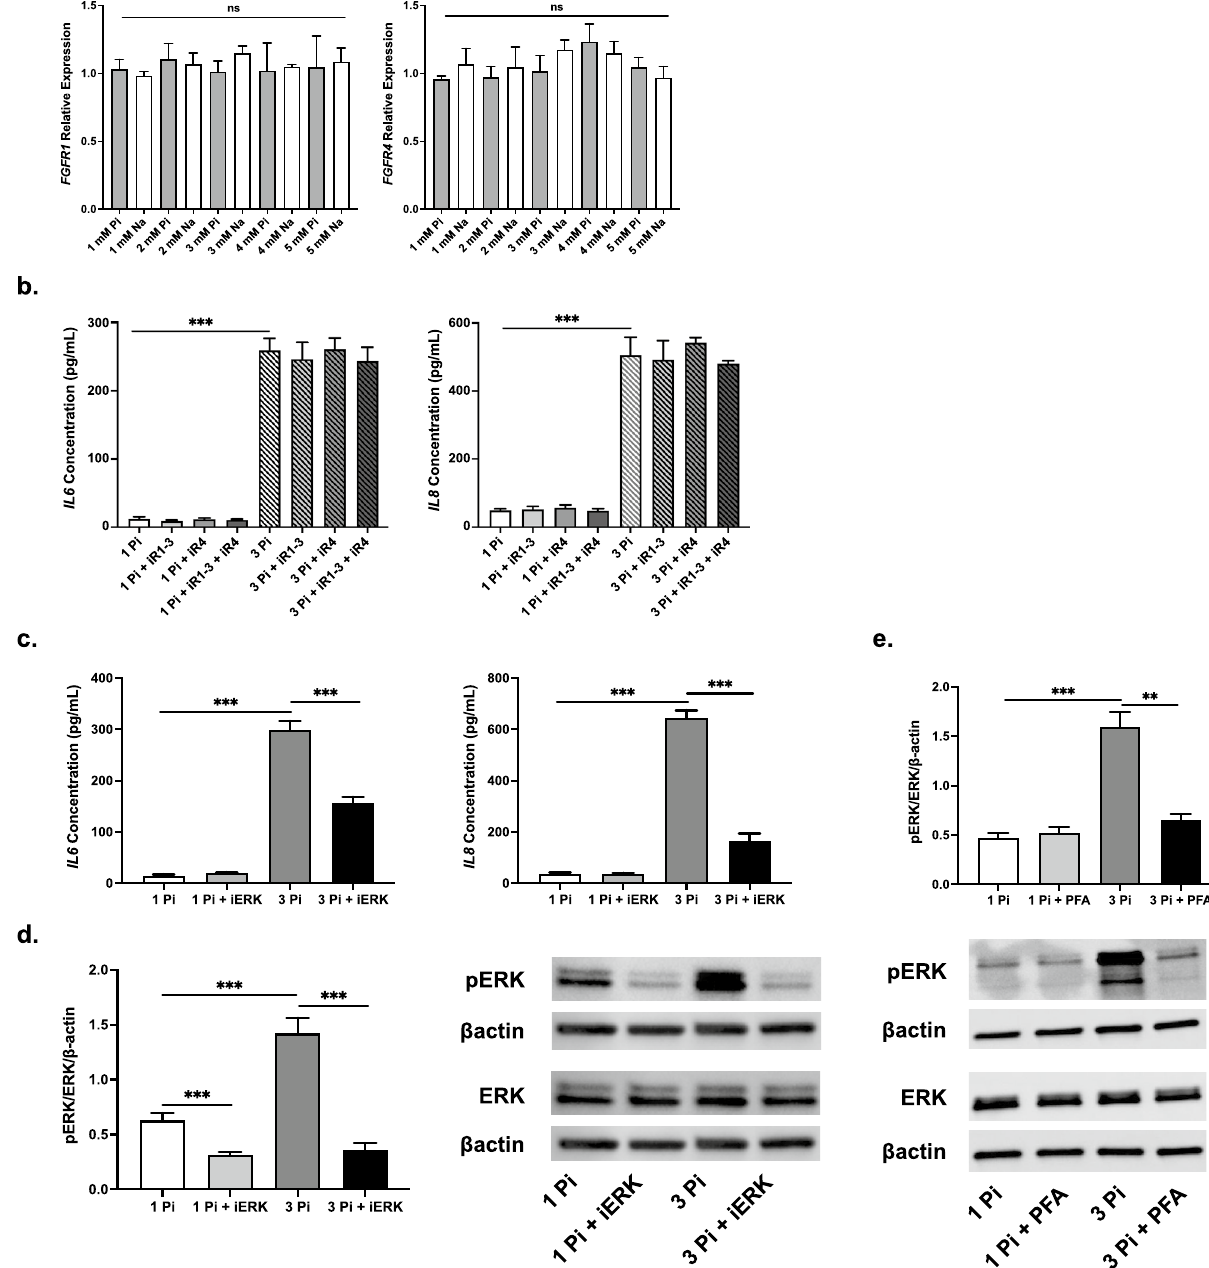
Figure 5. Inhibition of ERK, but not isoform-specific inhibition of FGFRs, attenuates inflammatory cytokine secretion in HBECs. ( a ) Relative mRNA transcript levels of FGFR1 and FGFR4 in BEAS-2B HBECs after 24 h sodium phosphate (Pi) or sodium sulfate (Na) stimulation. ( b ) IL6 and IL8 protein concentrations in conditioned media after Pi stimulation with iR1-3 and/or iR4 pretreatment. ( c ) IL6 and IL8 protein levels in conditioned media after Pi stimulation with and without iERK pretreatment. ( d ) Representative immunoblots and quantification of ERK phosphorylation in total protein extracts from BEAS-2B HBECs after Pi stimulation with and without iERK pretreatment. βactin serves as loading control. ( e ) Representative immunoblots and quantification of ERK phosphorylation in total protein extracts from BEAS-2B HBECs after Pi stimulation with and without PFA pretreatment. βactin serves as loading control. All experiments were reproduced 3 times with triplicates. All values are mean ± SEM with *p ≤ 0.05, **p < 0.01, and ***p < 0.001. Original western blots presented are available in Supplemental Fig. S2. Statistical significance was analyzed via two-way ( a , c – e ) or three-way ( b ) ANOVA followed by Tukey’s multiple comparison post hoc